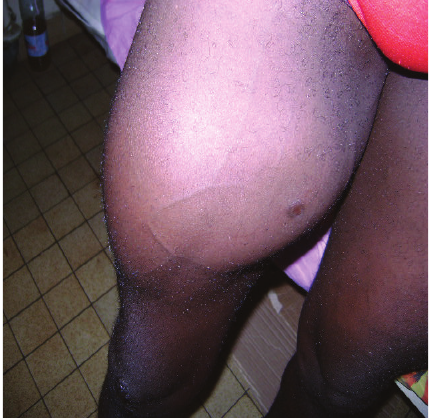
Figure 4: Large superficial femoral pseudoaneurysm with AVF fistula with palpable trill and audible machinery